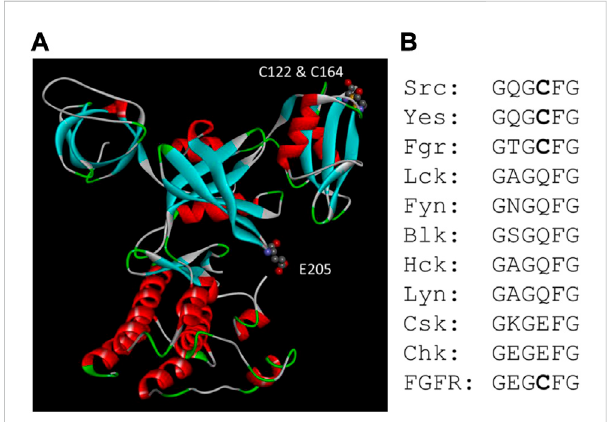
FIGURE 4 Csk motifs related to redox sensing. (A) . Positions of Glu205 and the disul fi de bond between Cys122 and Cys164 in Csk structure. (B) . Alignment of the Gly-loop sequence in Src, Csk and FGFR family kinases. All four members of the FGFR kinases have the same sequence in the